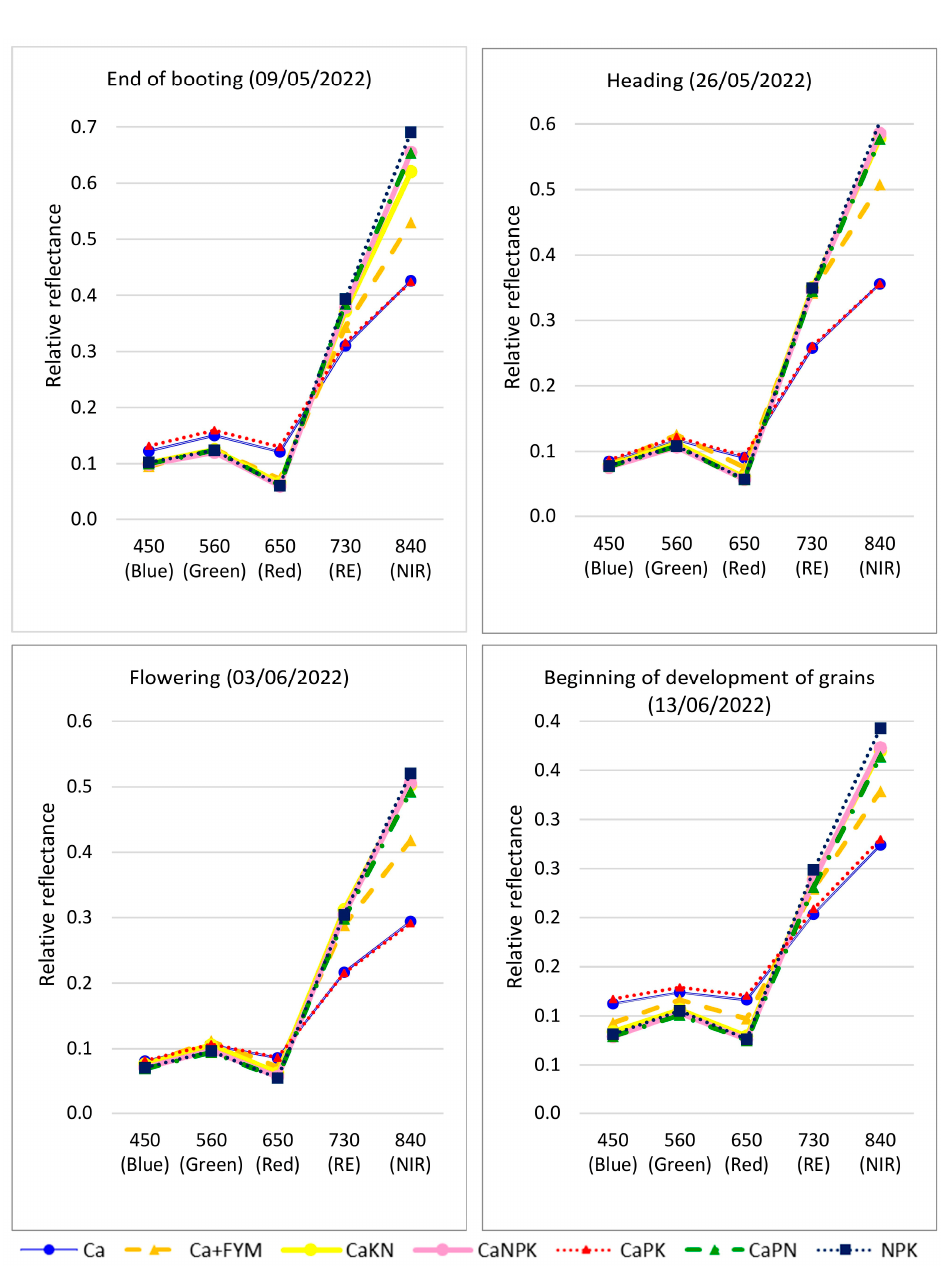
Figure 3. Spectral reflectance profiles for winter rye in experiment 2 (monoculture) in four growth stages